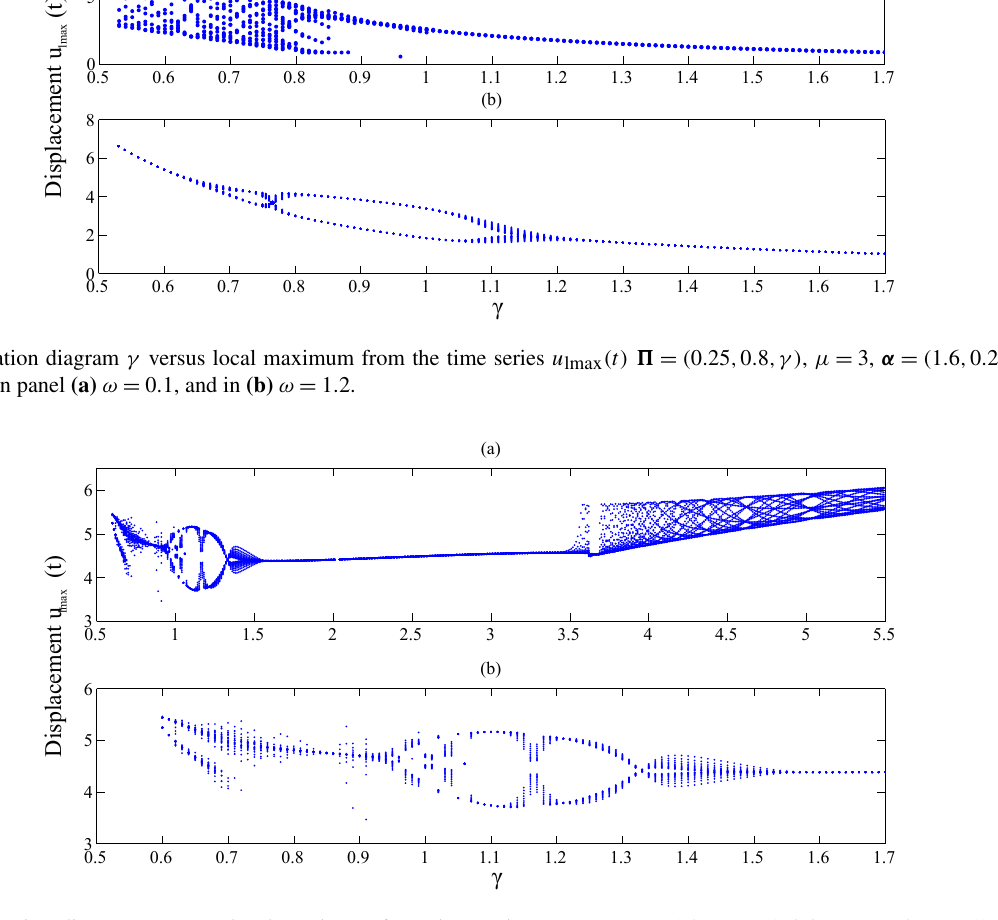
Figure 10. Bifurcation diagram γ versus local maximum from time series u lmax (t) , ω = 1 . 2, (cid:53) = ( 1 , 0 . 8 ,γ) µ = 3, α = ( 1 . 6 , 0 . 2 , 0 . 1 ) , sub-damped system. (a) There are three types of behavior: Type I, II, and III. (b) Enlarged view of Type